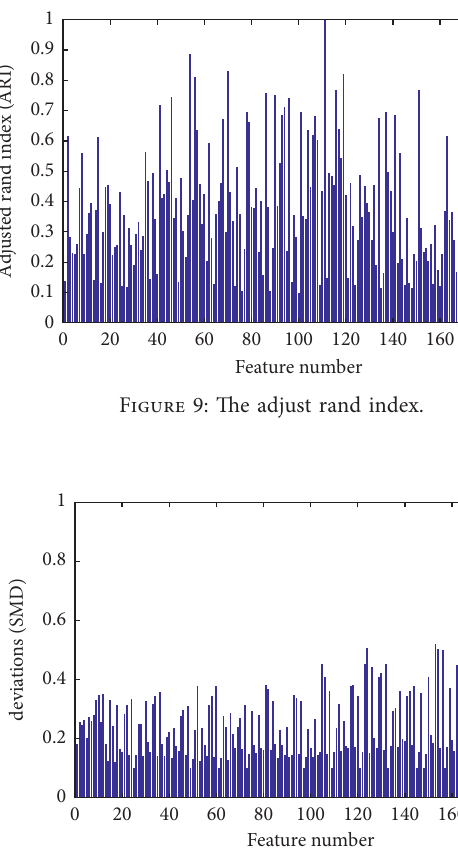
Figure 10: The sum of within-class mean deviations.